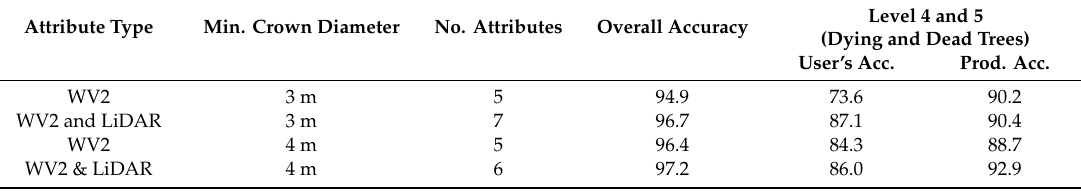
Table 9. Accuracies (Acc.) for an RF classification to identify dead and dying trees (level 4 and 5) with WV2 and LiDAR attributes for crowns with a diameter larger than 3 m (1089 total) and larger than 4 m (895 total). The RF classifier was set up with 1000 iterations in a 10-fold